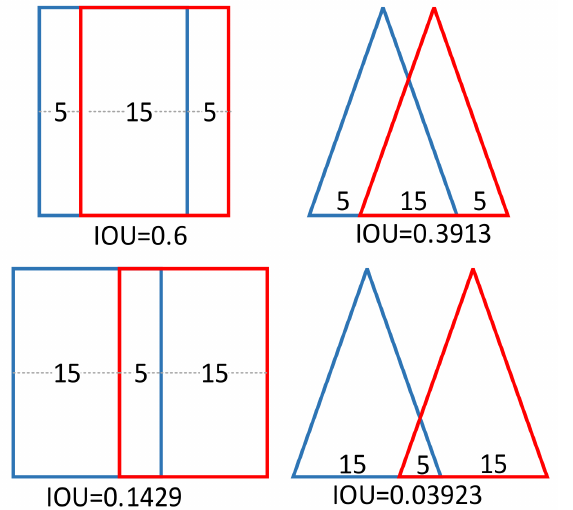
Figure 5. The difference between the IOU of the rectangle ( left ) and the IOU of the triangle ( right ) at the same grasping